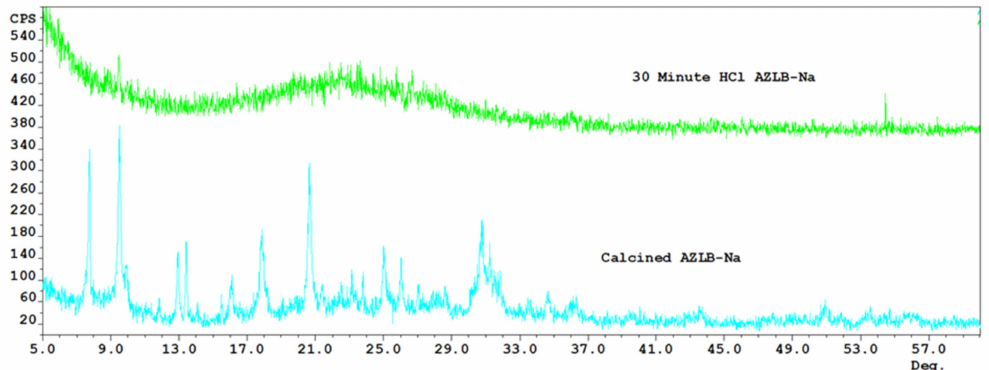
Figure 6. The XRD patterns of calcined AZLB-Na and 30 min HCl AZLB-Na.